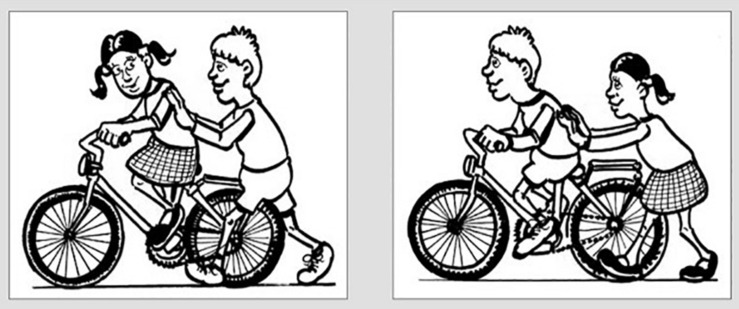
Illustration corresponding to the example item in (4).